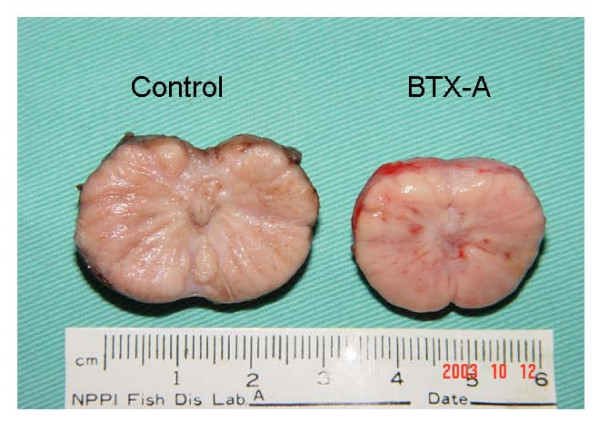
Coronal section of canine prostate one month after BTX-A or saline injection. Smaller in size and less indurations after BTX-A injection (B) than the control (A).